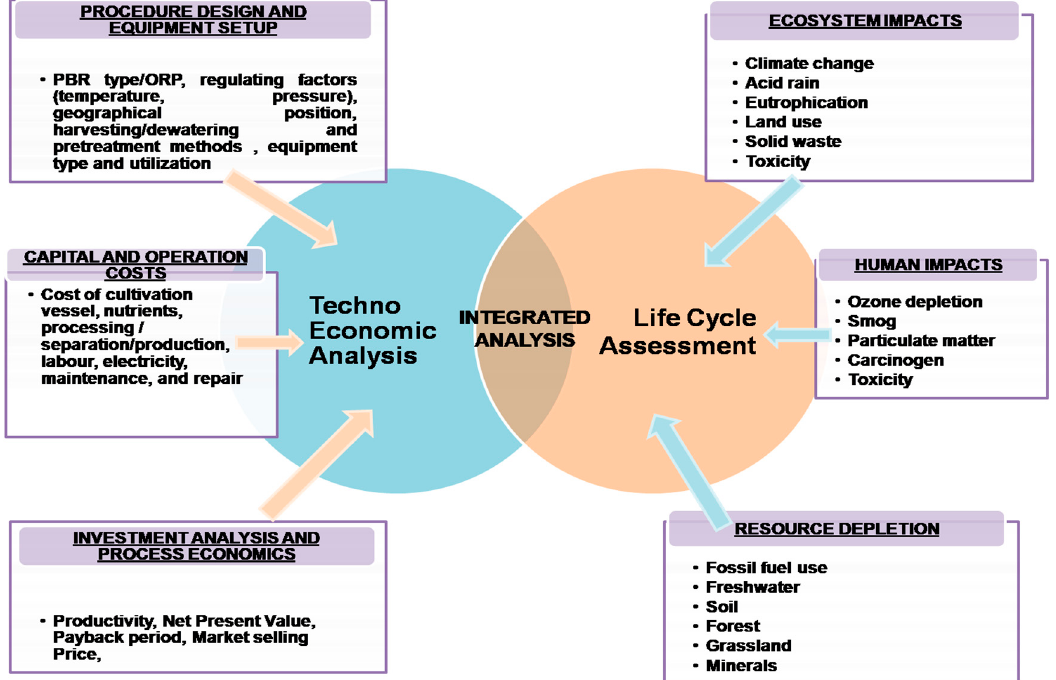
Figure 2. Factors involved in integrated techno-economic analysis and life cycle assessment. Table 1. Techno-economic analysis and life cycle assessment of some microalgal cultivation pro- cesses performed for biorefinery production.